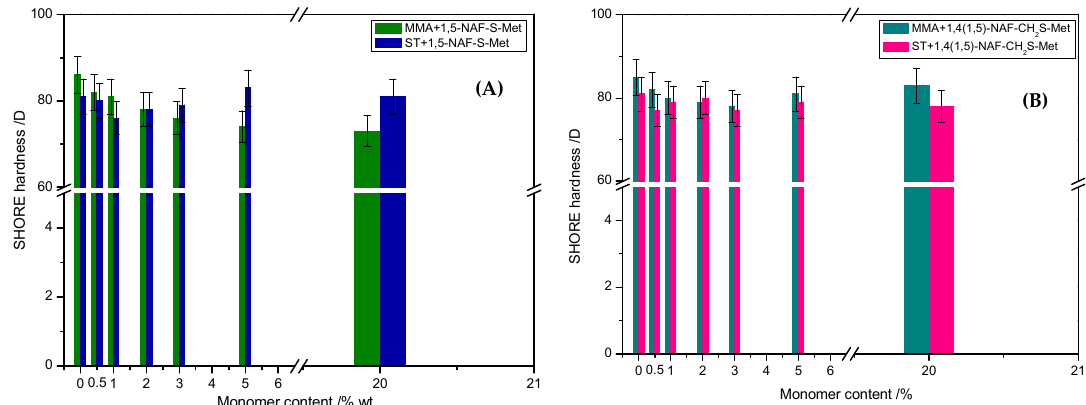
Figure 12. The values of Shore hardness tests of obtained cross-linked polymers with addition of 1,5-NAF-S-Met ( A ) and 1,4(1,5)-NAF-CH 2 S-Met ( B ).